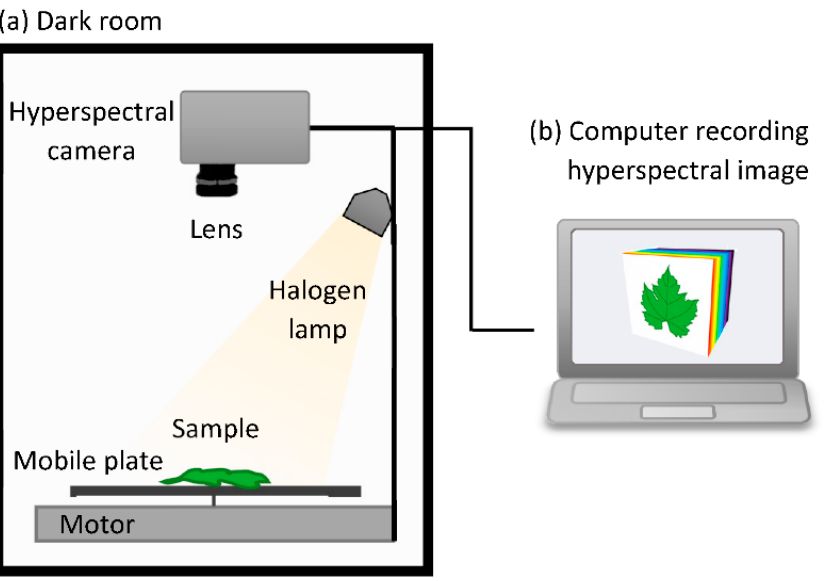
Figure 1. Schematic representation of the pushbroom hyperspectral imaging system used for the acquisition of the hyperspectral image database. ( a ) In a dark room with a halogen lamp as unique source of light, hyperspectral camera recorded the hyperspectral signature of each pixel of the sample moving under the lens ( b ) The system was controlled on a computer where all images were stored for later analysis. At the end of the recording, this resulted in a complete hyperspectral image, also called a hypercube, formed by the X and Y spatial axes and the Z spectral.